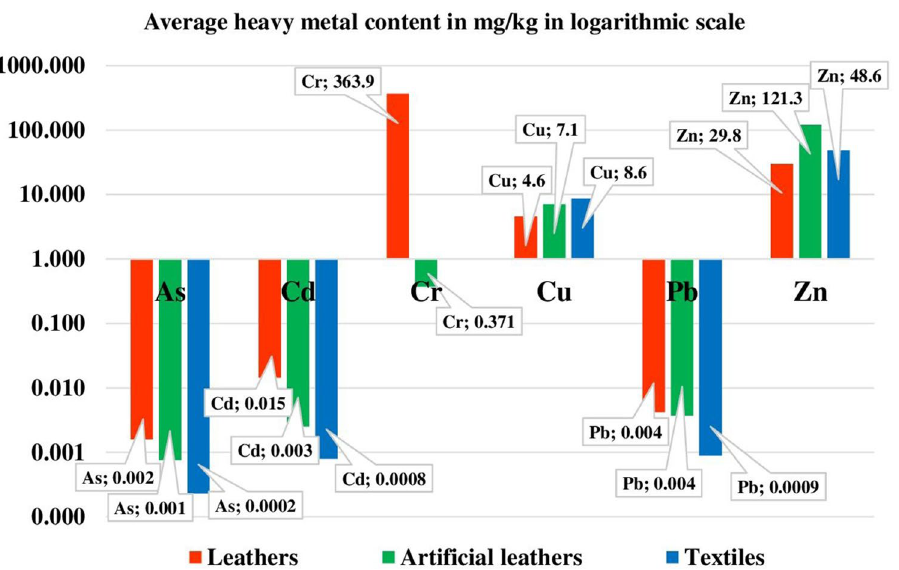
Figure 5. Average content of the tested metals in the extract from leathers, artificial leathers, and textiles. Source: Author’s own